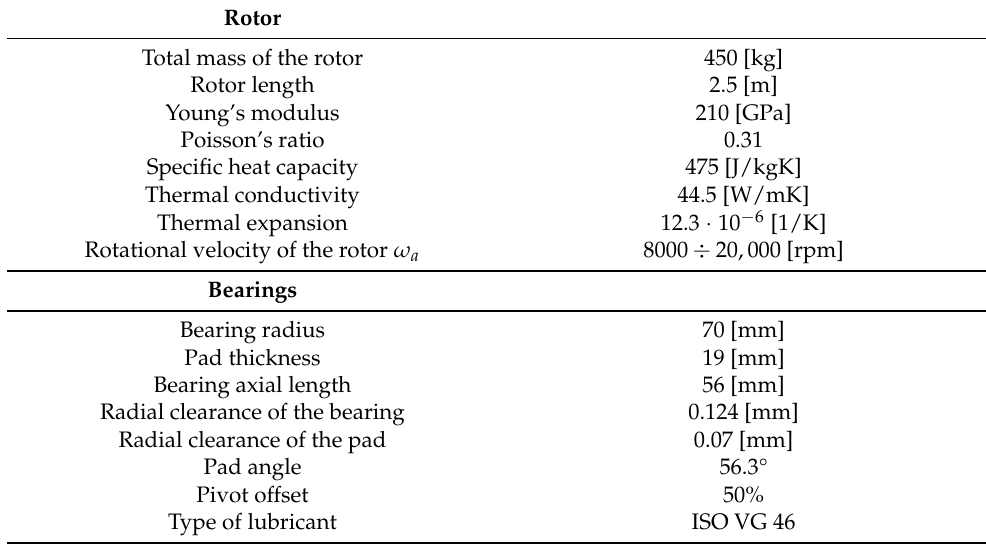
Table 1. Main characteristics and operating conditions of the test rig and of its TPJBs.